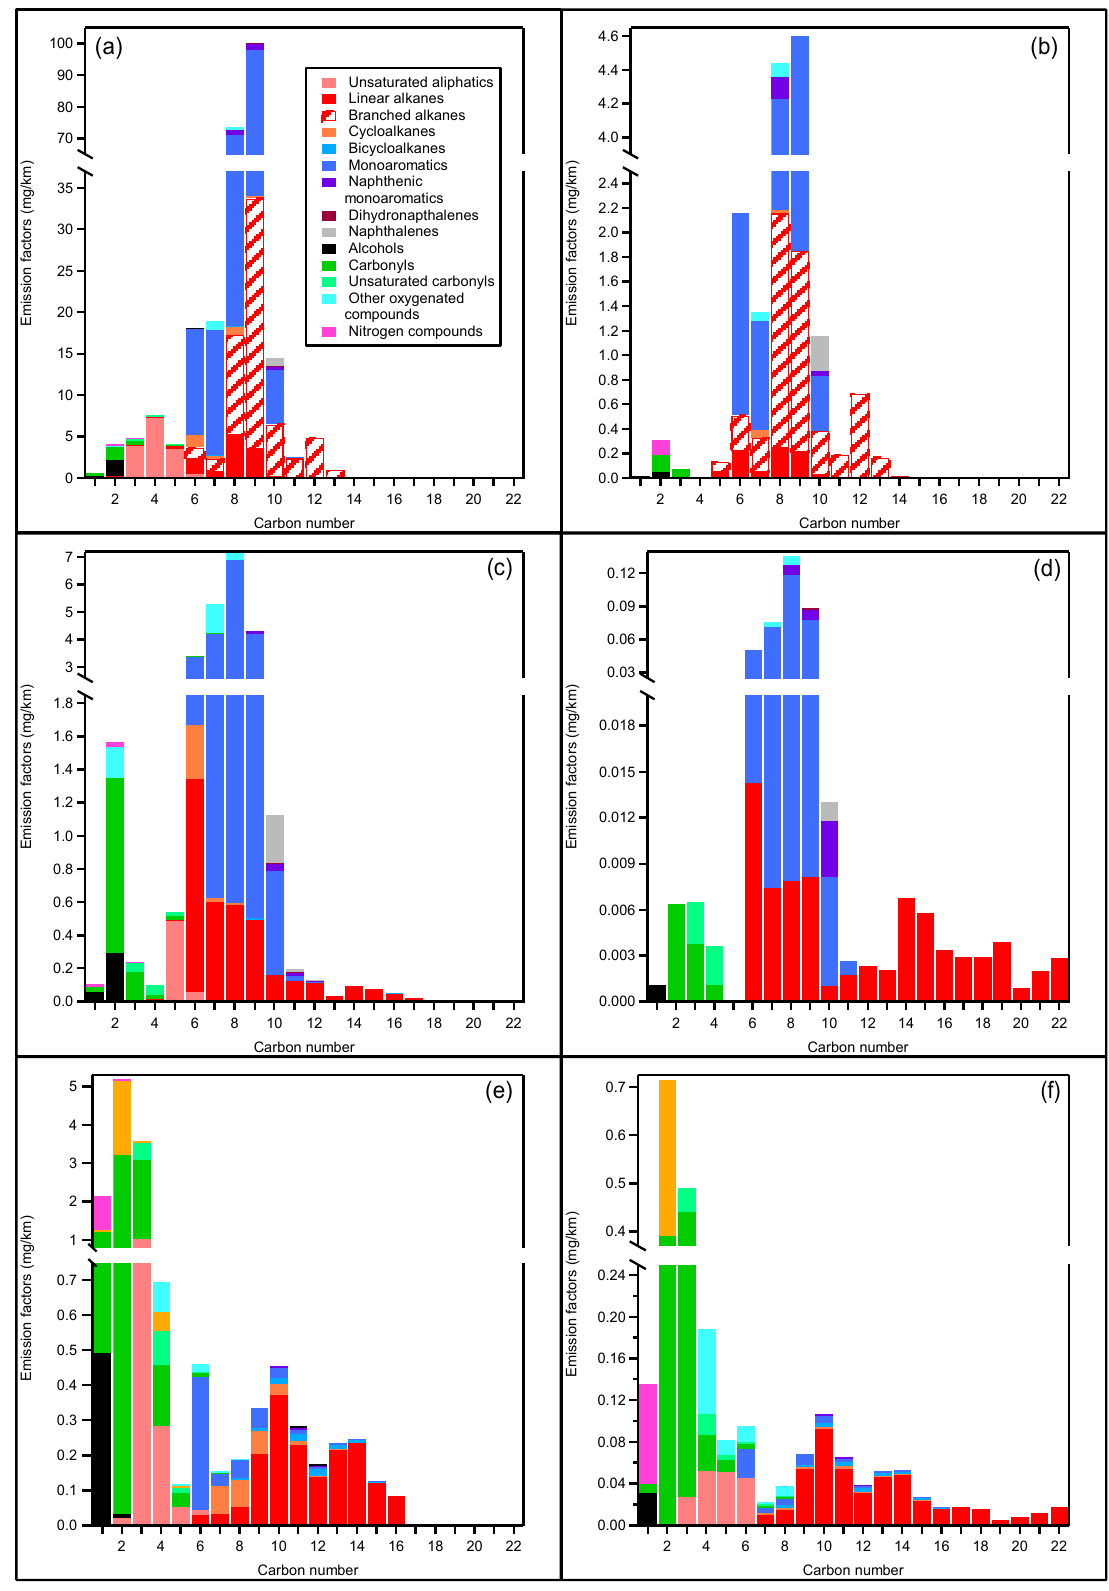
Figure 4. NMVOC EFs in mg/km as a function of carbon numbers for a typical ( a ) GDI CU cycle, ( b ) GDI MW cycle, ( c ) PFI CU cycle, ( d ) PFI MW cycle, ( e ) diesel CU cycle, and ( f ) diesel MW cycle. The different colors correspond to the main chemical classes measured by PTR-ToF-MS and